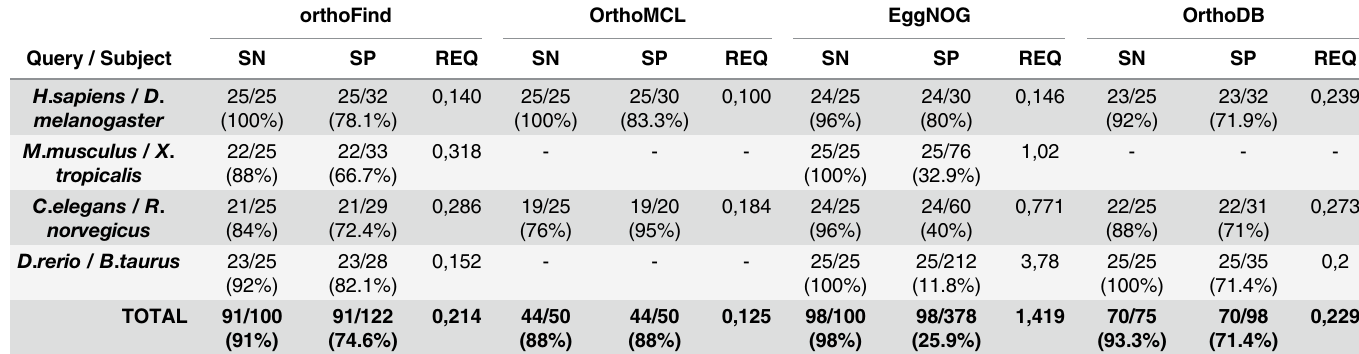
Table 1. Accuracy of orthoFinder and of another three methods measured with four sets of pairs of orthologs from different species. Results are shown for the different methods and sets, and the total accuracy is shown for each method. For each pair of orthologs, the sequence of the former species in the pair was used for searching the sequence of the latter one. When a method does not allow searching for orthologs in a specific species, a dash is shown. Sn = sensitivity (number of found orthologs / number of searched orthologs, and percentage), Sp = specificity (number of found orthologs / number of predic- tions, and percentage).